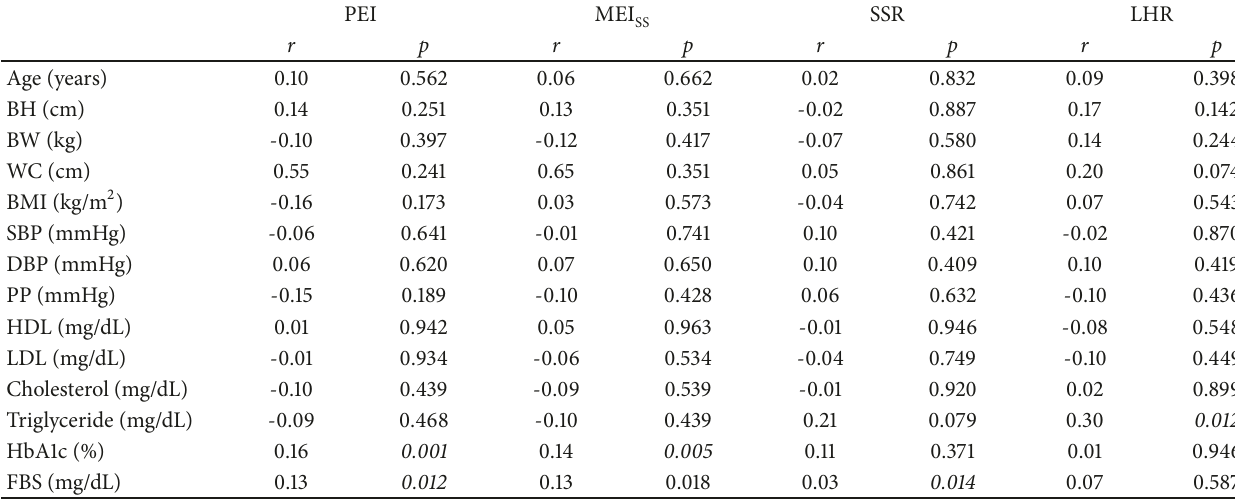
Table 3: Associations of demographic, anthropometric, hemodynamic, and serum biochemical data with computational parameters for autonomic function assessment in all testing subjects.